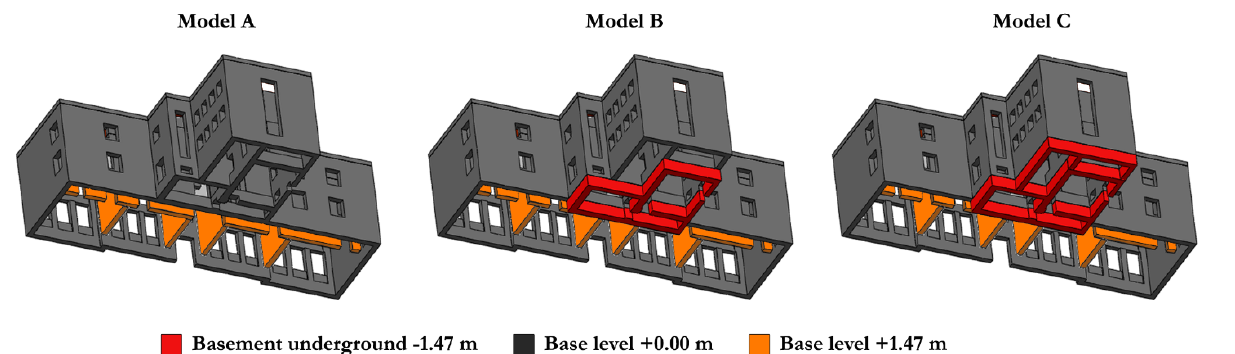
Figure 9: Geometry definition: different FE models prepared for the school and different base